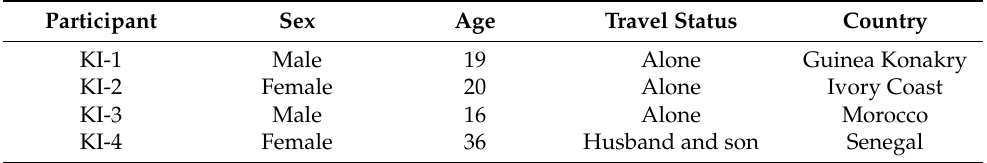
Table 1. Socio-demographic data of